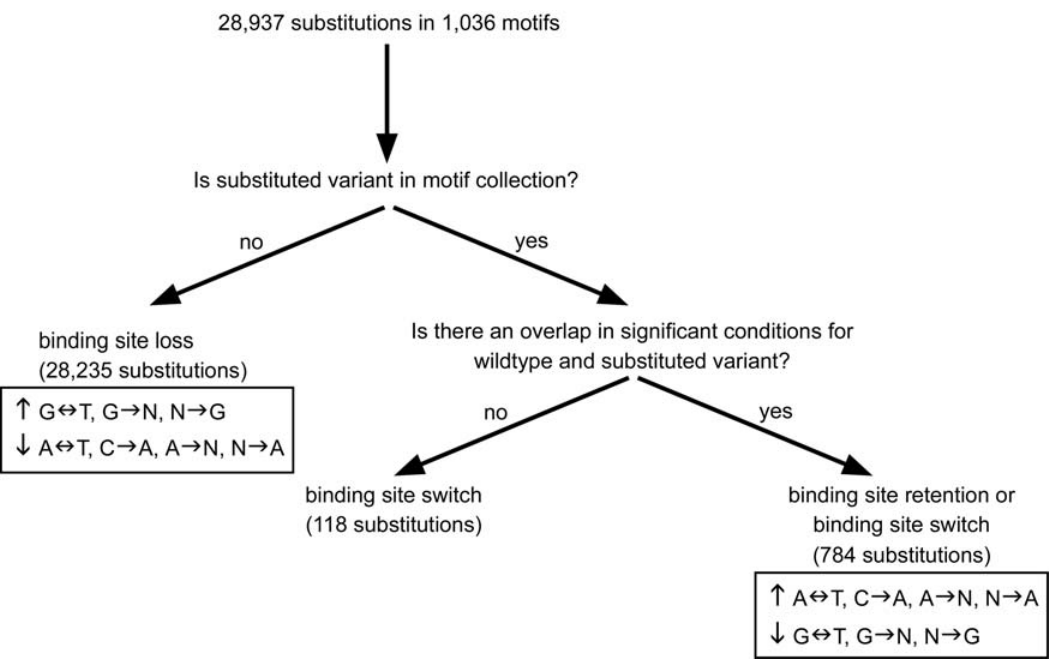
Figure 4. Statistics of the fates of substitutions in the filtered motif dataset. All possible single-nucleotide substitutions in the filtered motif dataset were considered. In order to obtain a non-redundant set of substitutions, if both ‘wild-type’ motif and its substituted variant were members of the filtered motif dataset then the reverse substitution was not examined. In total 28,937 substitutions were examined. Cases where the substituted variant was not a member of the filtered motif dataset were considered as binding site losses. Of the remaining 702 substitutions, 118 constitute clear cases of binding site switches, as the ‘wild-type’ and substituted variant do not share biological conditions in which both of them are presumed to be active based on their EC scores. For the remaining 584 substitutions the effect of the substitution (conservation of the binding site or binding site switch) can only be determined by the similarity in mean expression profiles, as in these cases both ‘wild-type’ and substituted variant are coherent in a shared condition. Substitution types that are over-/under-abundant in the categories of ‘‘binding site loss’’ or ‘‘binding site retention or binding site switch’’ are denoted, with upward- and downward-pointing arrows indicating over- and under-representation, respectively.